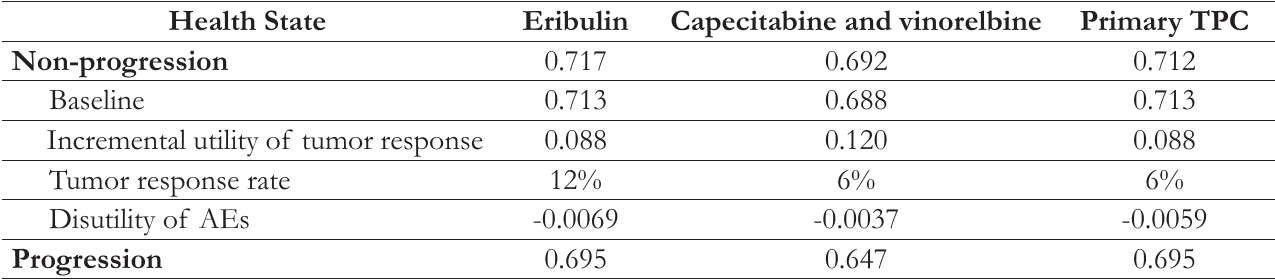
Table 6. Utility Scores